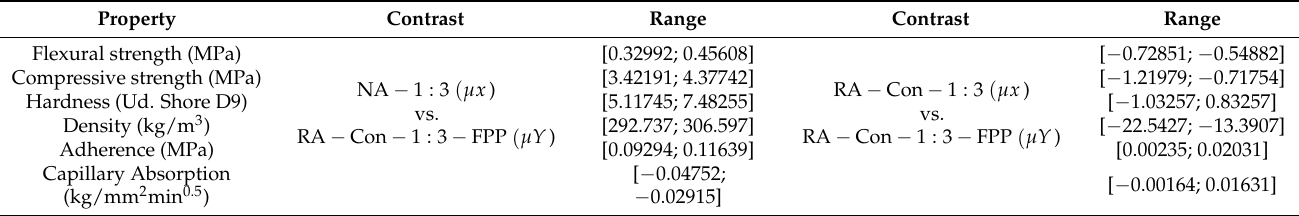
Table 16. Confidence intervals for mean difference at 95%